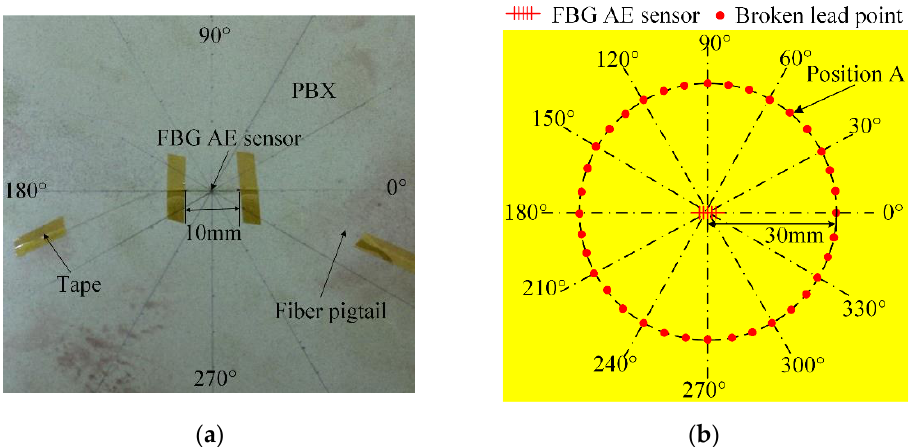
Figure 7. FBG AE sensor directionality experiment. ( a ) Photograph of the FBG AE sensor on the PBX